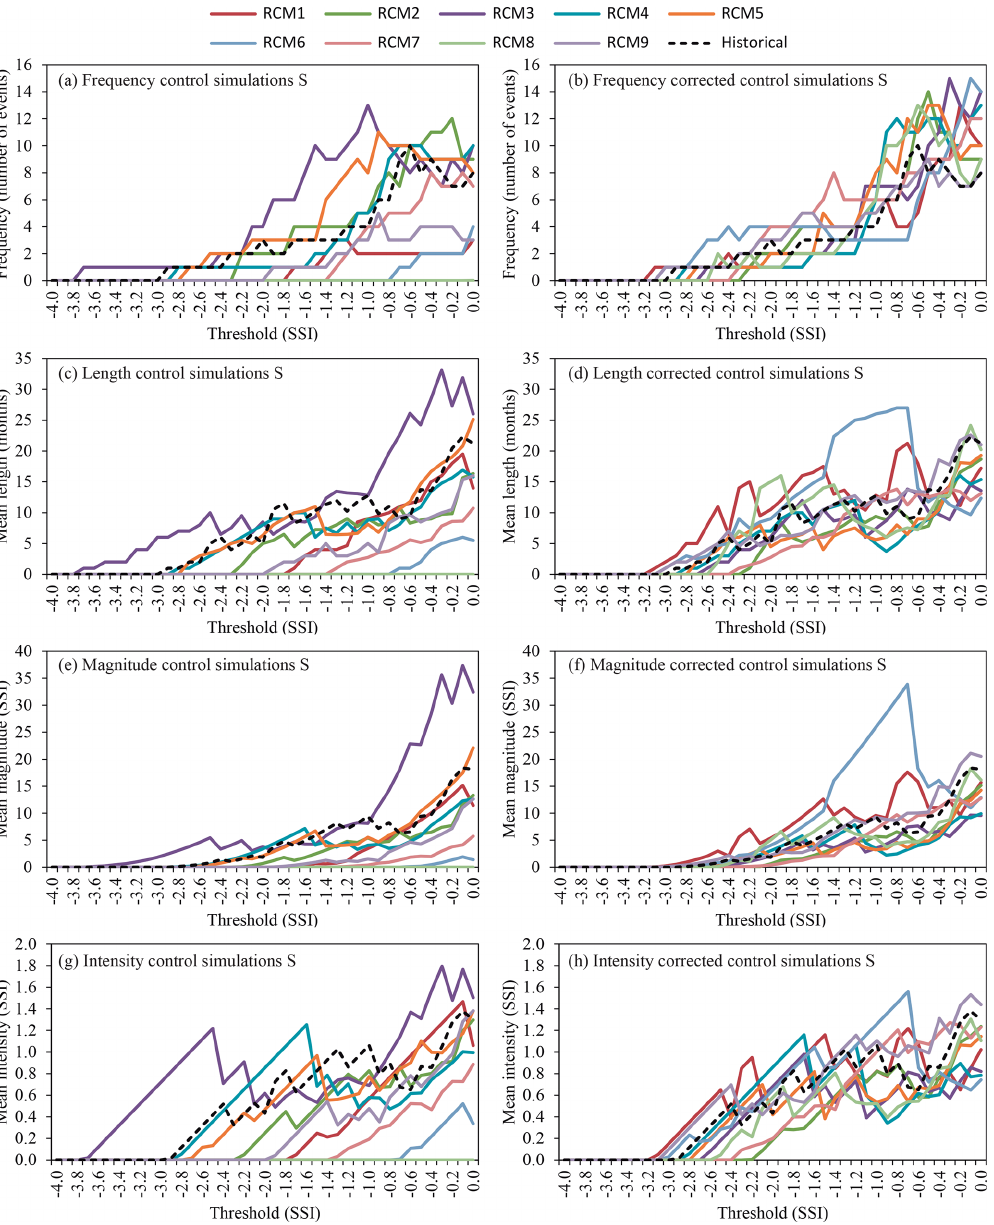
Figure 9. Drought statistics (frequency, length, magnitude and intensity) of the period (1972–2001) for the historical and control simulation series (a, c, e, g) and the historical and corrected control simulation series (b, d, f, h) for streamflow (hydrological